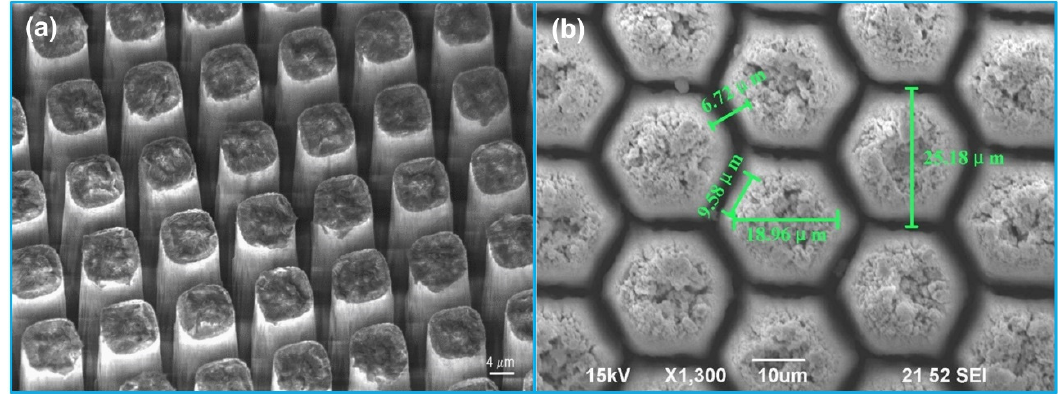
Figure 5. SEM images of pillar arrays for a piezo-composite micromachined ultrasound transducer (PC-MUT). ( a ) PMN-PT single crystal pillars for a 60 MHz PC-MUT. Reprinted from [94] with permission. ( b ) PZT-5H ceramic hexagonal pillars for a 50 MHz PC-MUT. Reprinted from [100] with permission.